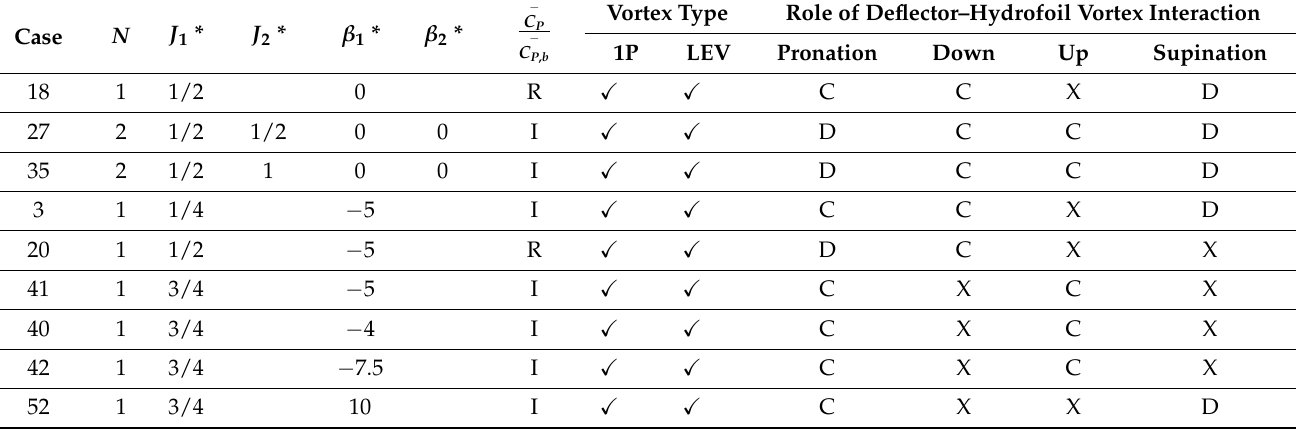
Table 3. Relationship between C P and flow field for the nine analyzed cases (R: Reduced, I: In- creased, C: Constructive, D: Destructive, X: No effect; tick mark represents the existence of vortex).